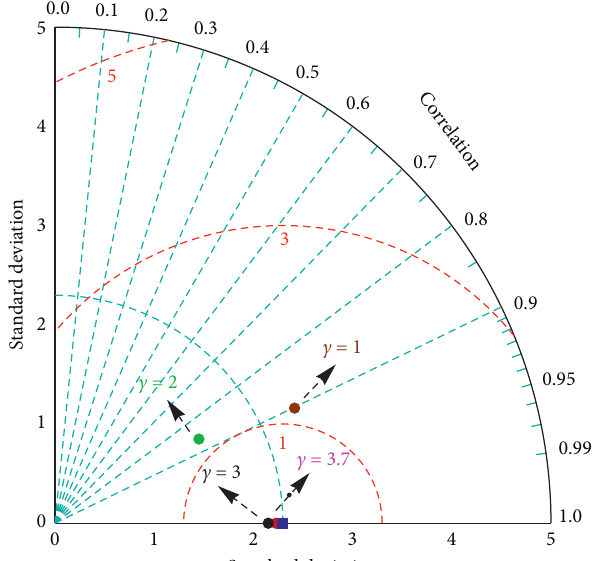
Figure 6: Taylor’s diagram for the model of the centers in Example 1. The rectangle on the x -axis represents the observations, and the red- dashed contours indicate the centered Root Mean Square Errors.